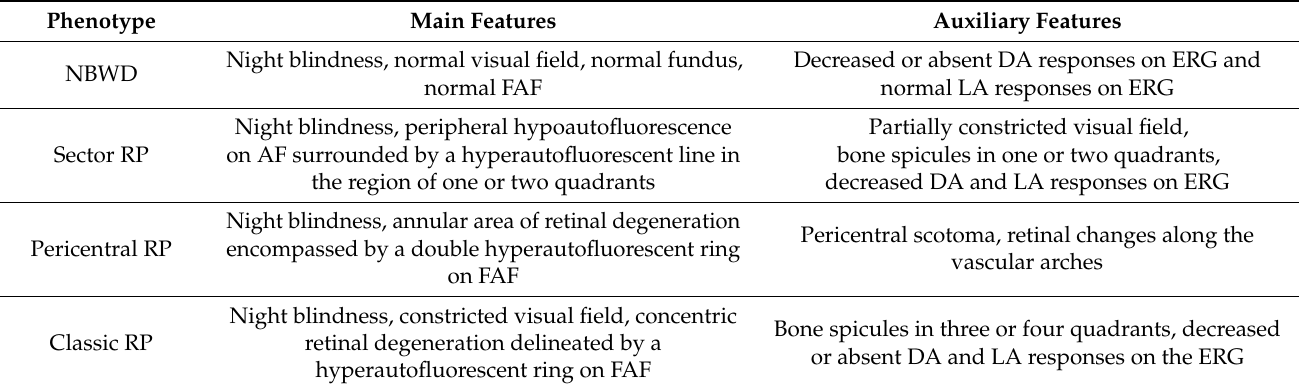
Table 3. Features of the four phenotypic